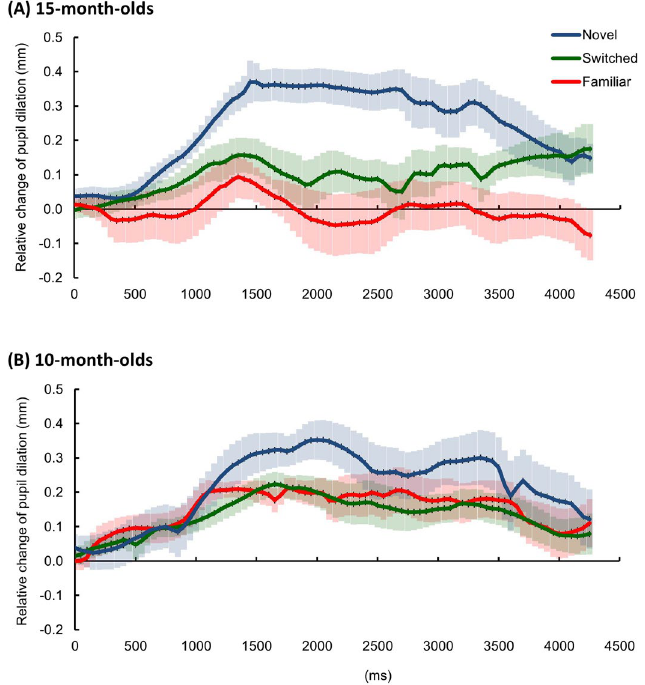
Figure 2. Pupil dilation results. Mean relative change of the pupil size in each condition for ( A ) 15-month- olds and ( B ) 10-month-olds, respectively. The pupil size data were locked to the onset of the sound, and the mean pupil size over the 1000 ms window before sound onset were the baseline used to normalize the data in each condition for each participant. The data from sound onset to the end of the video (4300 ms in total) were divided into 86 50-ms time bins. The shaded areas represent ± 1 SE of the mean in each time bin in each condition.